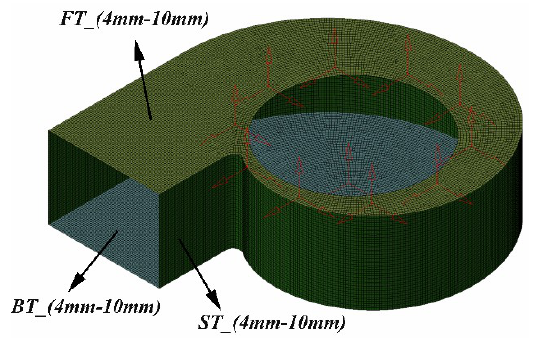
Figure 19. The volute parameterization structure.